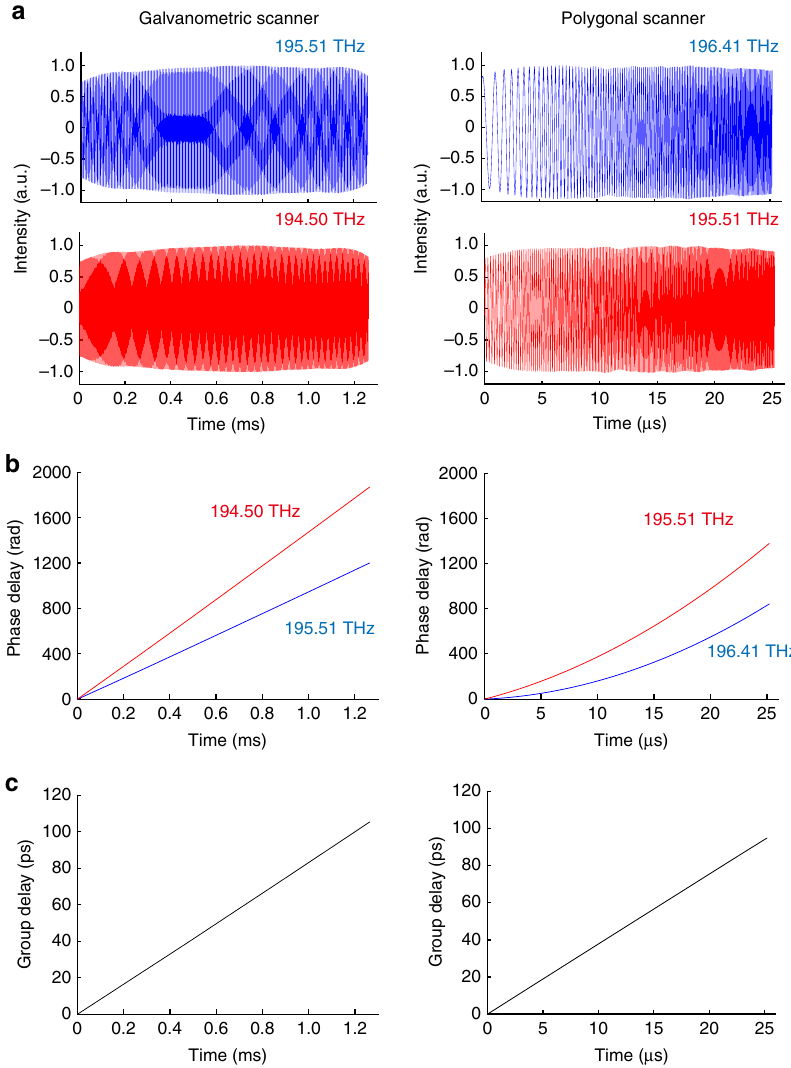
Fig. 3 Characterization of the phase and group delays added by the delay lines. a Measured continuous-wave interferograms at the two different frequencies. b Phase delays of the CW interferograms. c Group delays evaluated from the phase delays at the two different